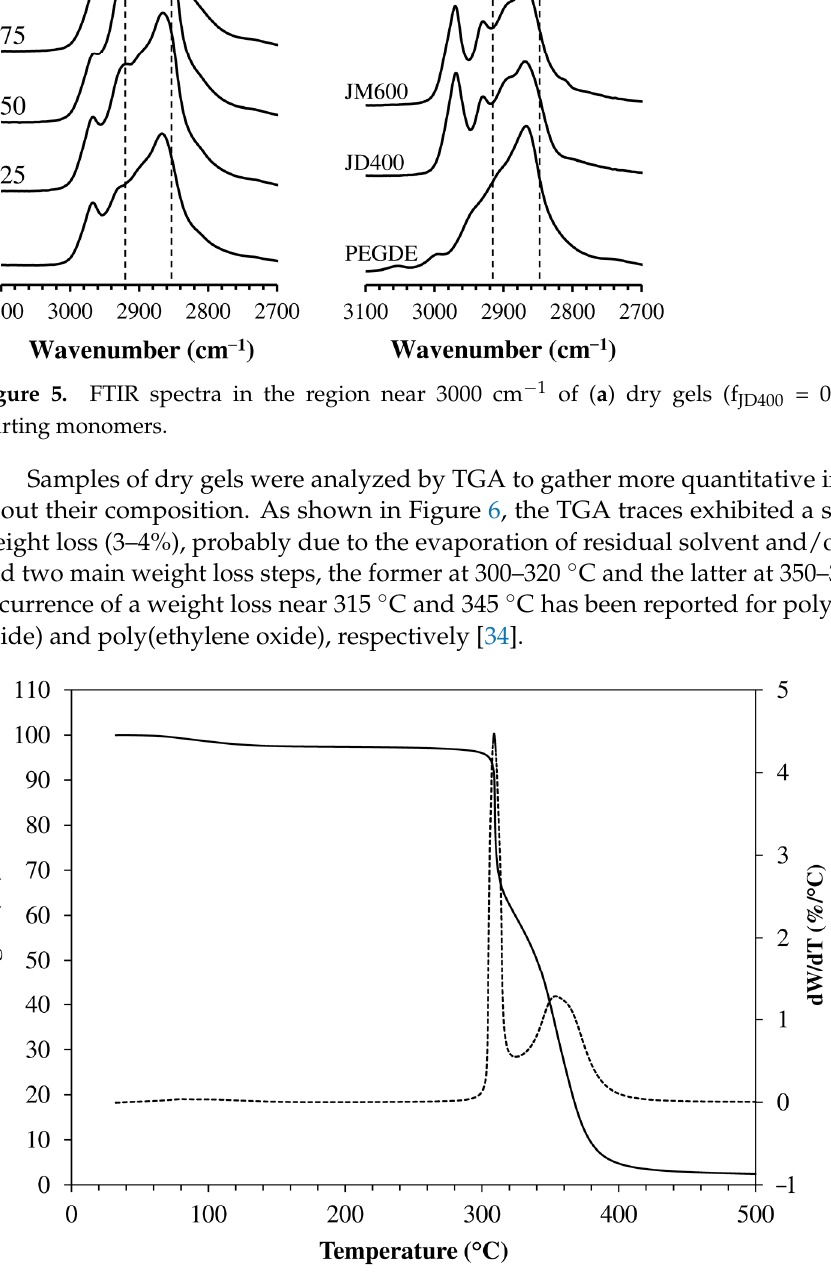
Figure 6. Typical traces obtained in high resolution TGA experiments carried out under nitrogen (sample